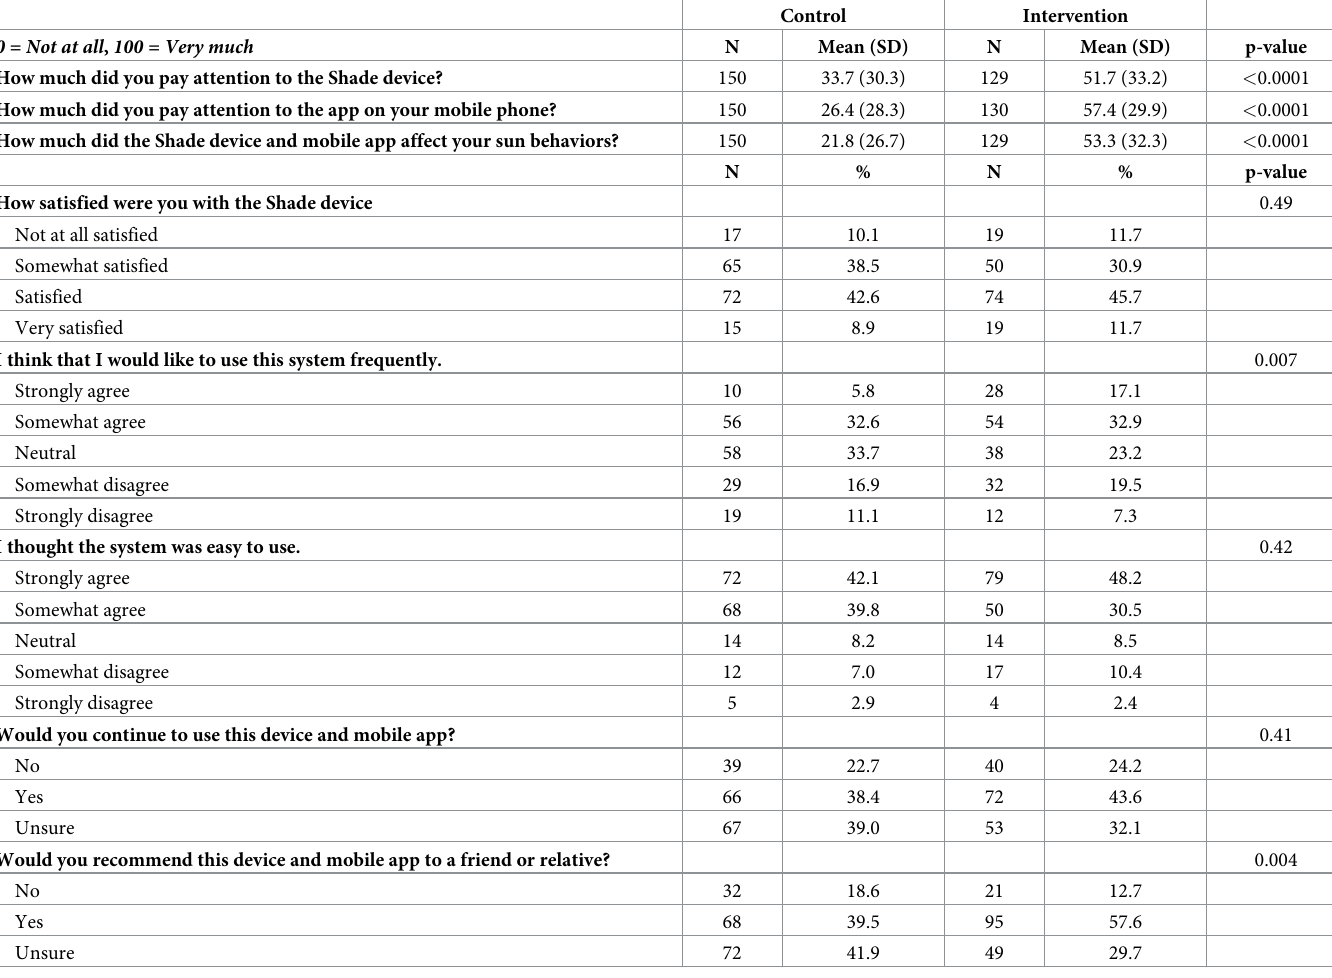
Table 8. Device intervention satisfaction at week 12 by